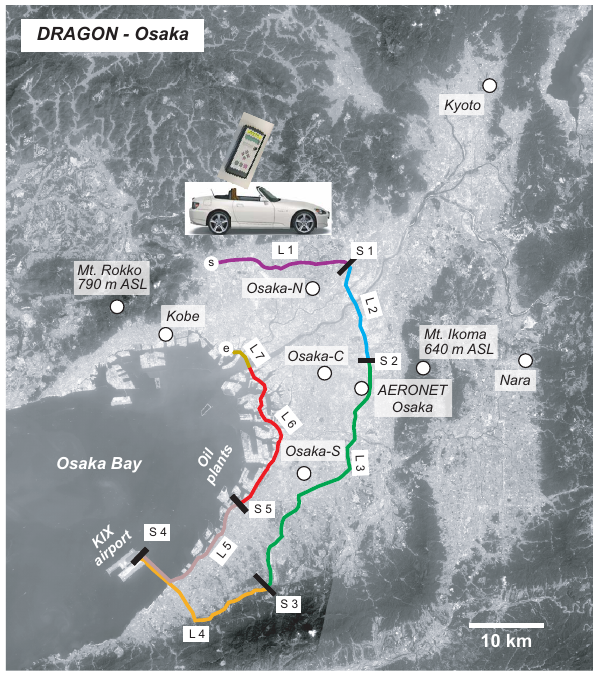
Figure 3. Temporal variation of AOT at a wavelength of 500nm during the DRAGON-Japan period. Measurements were taken at Fukue Island, Fukuoka, Nishi-Harima, Osaka, Noto, and Tsukuba (see Fig. 2). The error bars (shaded gray) represent standard devia- tion at each site. Red lines represent average values at each site.